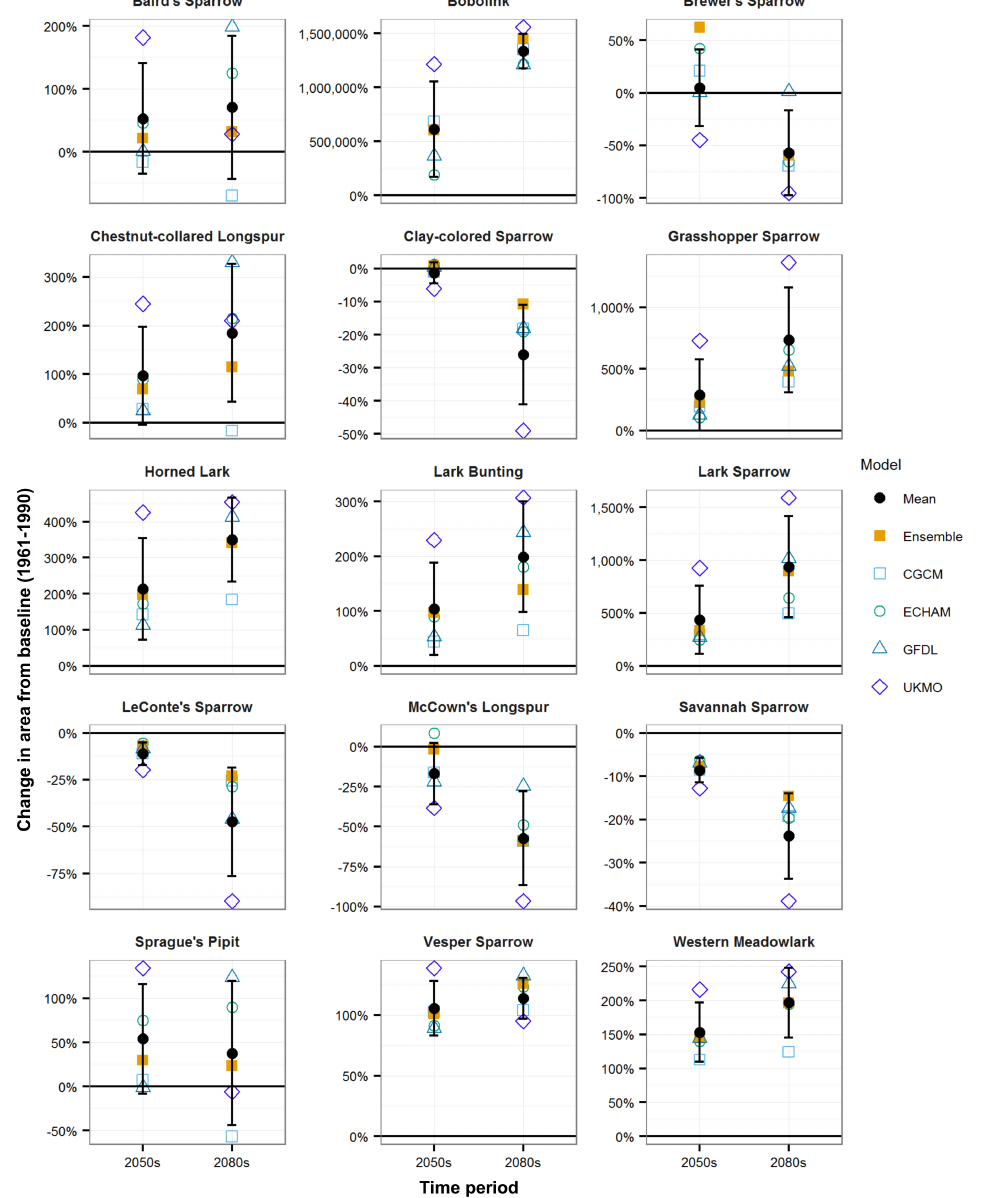
Fig. 2 . Projected change in the area of suitable climate in Alberta, Canada from the historical baseline (1961–1990) for two future time periods, based on North American models. The mean change (± 95% CI [black circles]) was determined from the four unique global climate models (GCMs) (CCCMA CGCM3.1; MPI ECHAM5/MPI-OM; GFDL CM2.1; UKMO-HadGEM1 [open symbols]). Changes in areas projected using the ensemble climate data (yellow squares) correspond to the maps in Figure A3.2. Note the difference in scales between